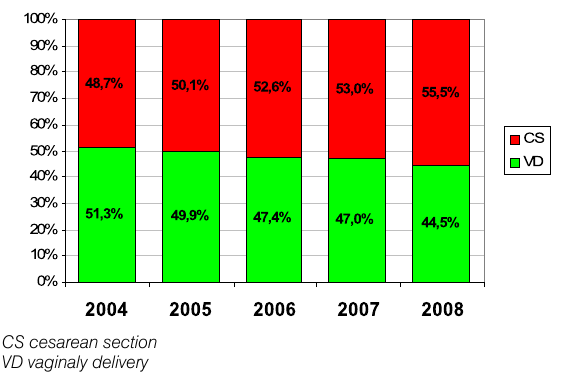
Figure 1. Delivery mode (cesarean section and vaginaly) between 2004 to 2008